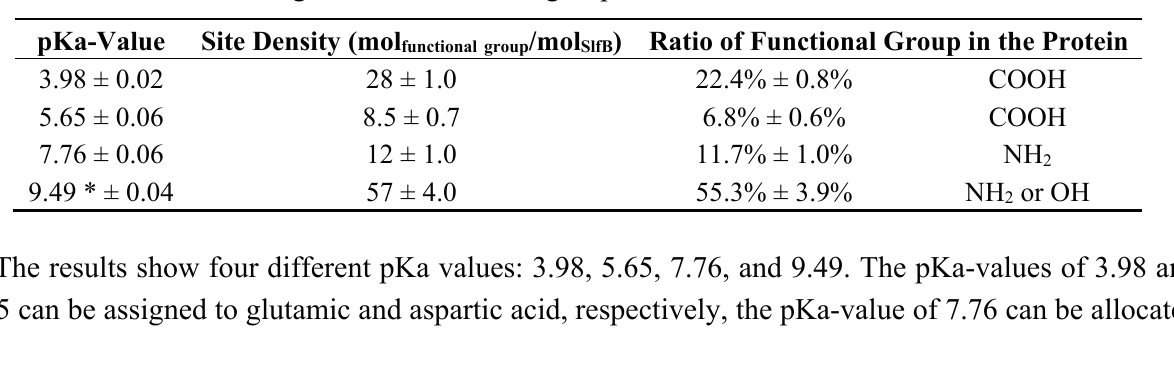
Table 1. Determined pKa-values of SlfB and modification rates evaluated by potentiometric titration; * can be assigned to NH 2 - or